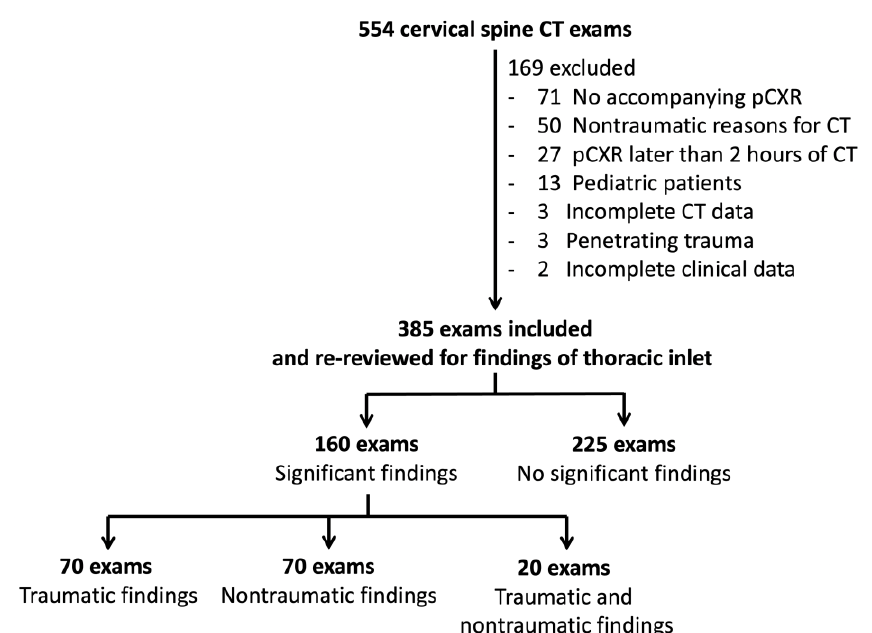
Figure 1. Flowchart of patient inclusion.